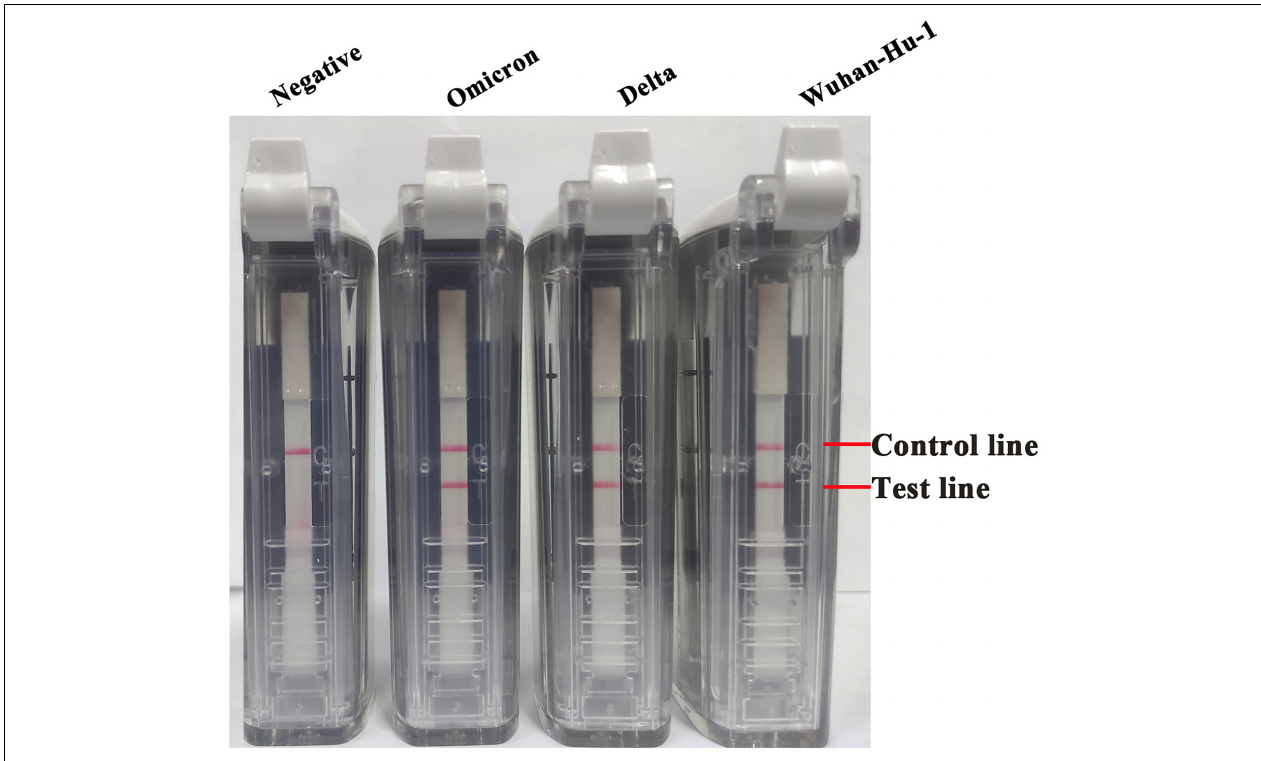
FIGURE 5 | The applicability of the RT-LAMP-VF assay detected multiple SARS-CoV-2 mutants. Multiple RNA transcripts of variants including Wuhan-Hu-1 strain, Delta, and Omicron were used to evaluate the RT-LAMP-VF assay, and the concentration of each RNA transcript was 20 copies/ µ l.